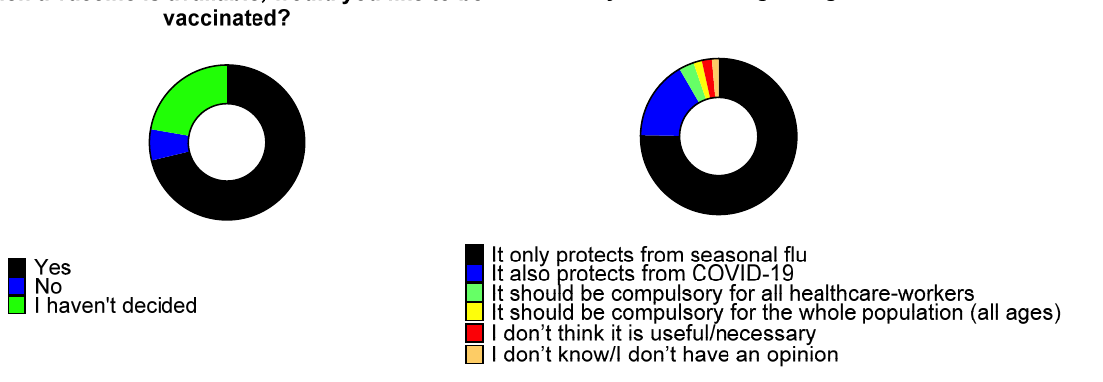
Figure 4. Healthcare workers’ opinions regarding isolation and vaccination.